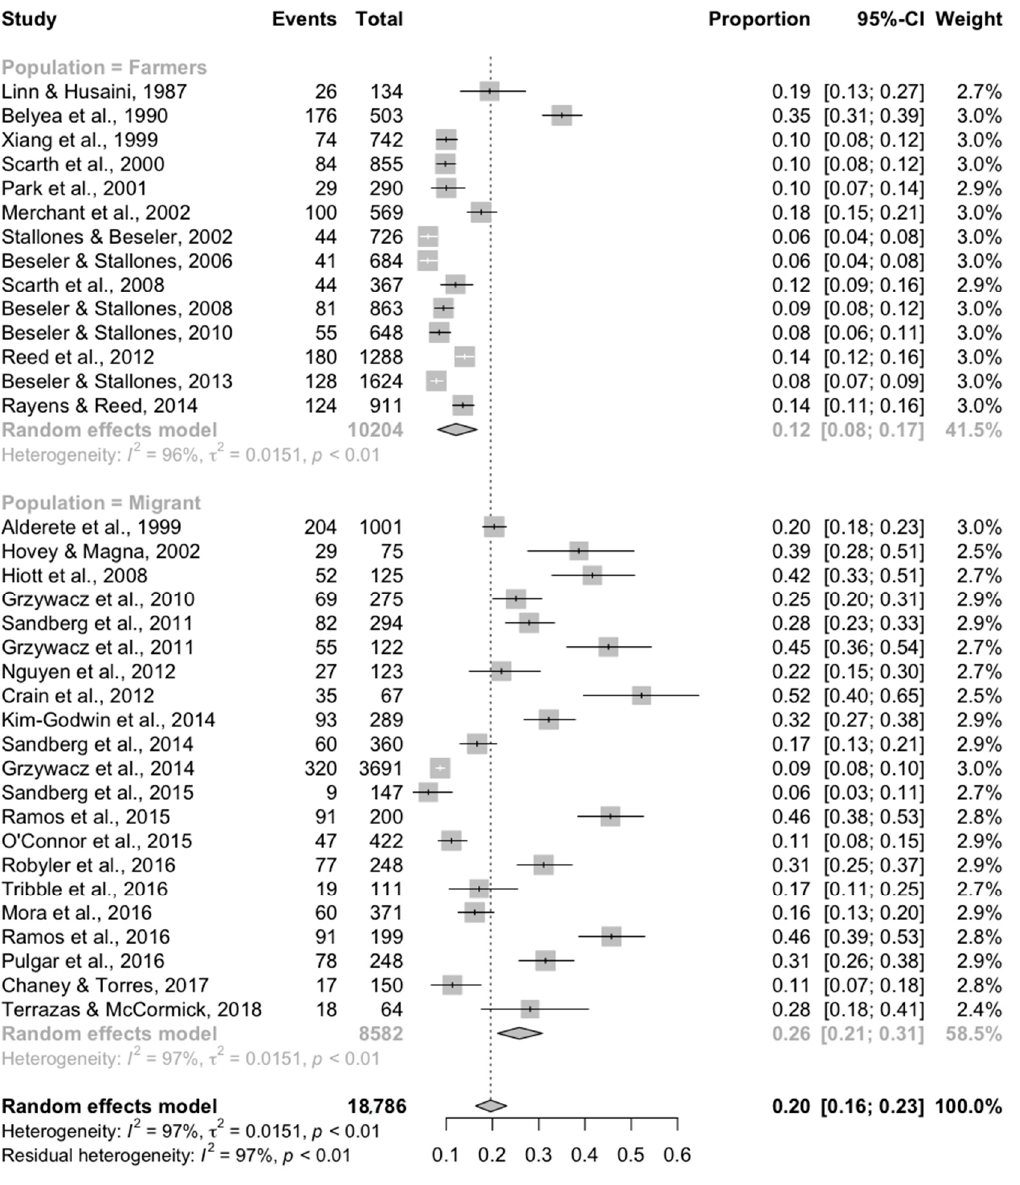
Figure 4. Results of the subgroup meta-analysis of the 35 studies conducted in the United States reporting a binary outcome (yes/no) using the CES-D/DR scale to measure depression in farming populations (“Farmers” = non-migrant farming population; “Migrant” = study restricted to migrant farmworkers). Similarly, the subgroup analysis for studies reporting a continuous outcome (Figure 5) did not reduce the residual heterogeneity but did reveal point estimates between the population types that did not overlap. For studies evaluating a non-migrant farming population (n = 6), the mean scale score was 6.18 (95% CI = 5.52–6.85; I 2 = 86%). For studies of migrant farmworkers (n = 14), the mean scale score was 8.68 (95% CI = 7.37–9.99; I 2 =